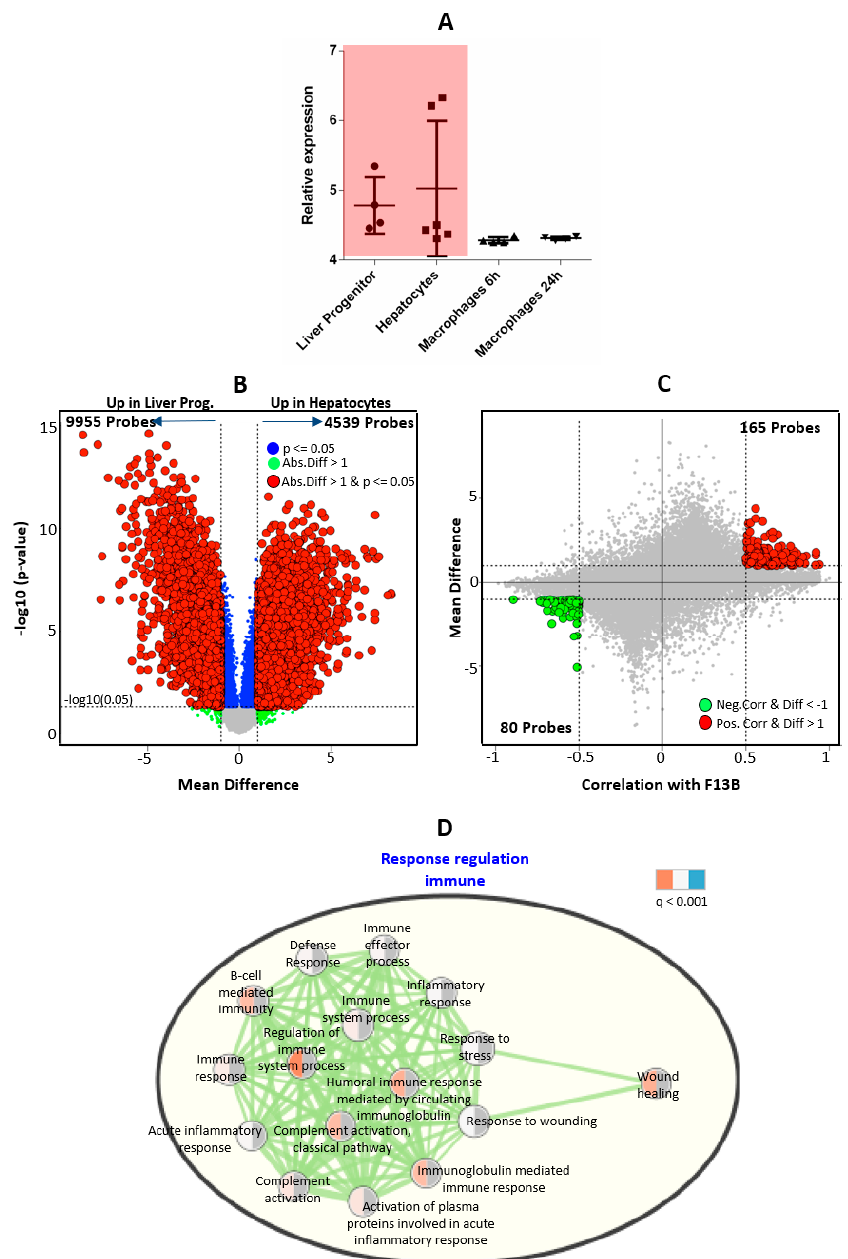
Figure 2. An expression analysis of F13B in liver progenitor cells and hepatocytes. ( A ) A box plot of F13B expression in liver progenitor cells, hepatocytes, and macrophages. ( B ) A volcano plot of differentially expressed genes between liver progenitor cells and hepatocytes at red: significant p -value < 0.05 and absolute mean difference between liver progenitor and hepatocytes above 1; green: the absolute mean difference between liver progenitor and hepatocytes above 1 but p -value > 0.05; and blue: statistical p -value < 0.05, but the absolute mean difference between liver progenitor and hepatocytes < 1. ( C ) The Bland–Altman plot between the correlation of F13B expression with other gene expressions and the mean expression difference of the genes between liver progenitor cells and hepatocytes; red: significantly positively correlated genes at Pearson’s-Correlation > 0.5 and the absolute mean difference between liver progenitor and hepatocytes > 1; green: significantly negatively correlated genes at Pearson’s Correlation < − 0.5 and the absolute mean difference between liver progenitor and hepatocytes > 1. ( D ) A gene ontology analysis of significant genes from the Bland–Altman plot in part C .